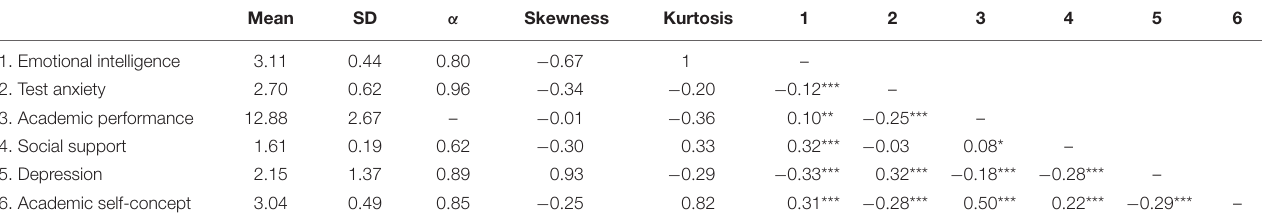
TABLE 1 | Descriptive statistics and correlations among the main variables.